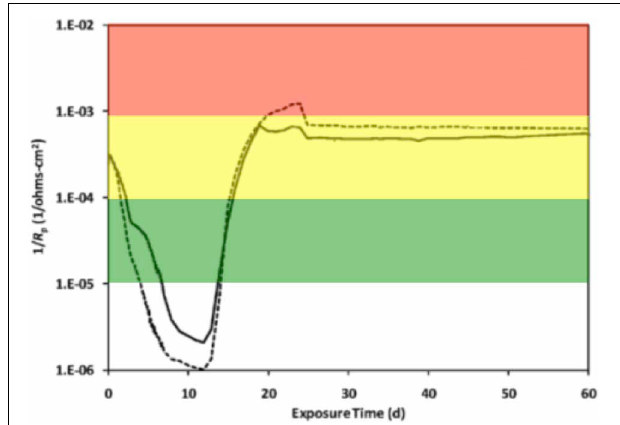
FIGURE 1 | An instantaneous corrosion rate (1/ R p ) curve adapted from Aktas et al. (2010). The basic shape of the curve represents the corrosion of C1020 metal over time. 1/ R p = ( ) 10 − 5 ohms − 1 cm − 2 , < 0.0254mmpy; ( ) 10 − 4 ohms − 1 cm − 2 , 0.0254–0.127mmpy; ( ) 10 − 3 ohms − 1 cm − 2 , 0.127–0.508mmpy.